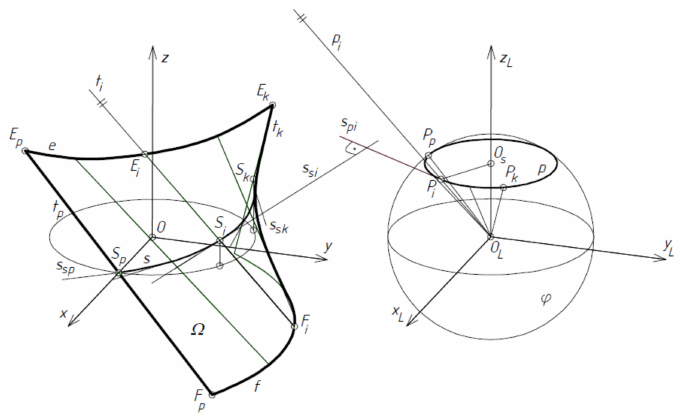
Figure 16. Central sector Ω determined on the basis of line of striction s and spherical indicatrix p determining warped